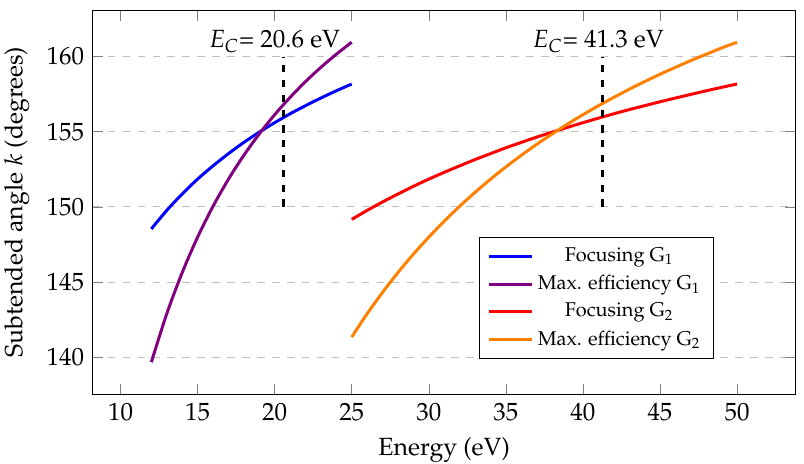
Figure 3. Comparison between the subtended angles for focusing condition and maximum efficiency.